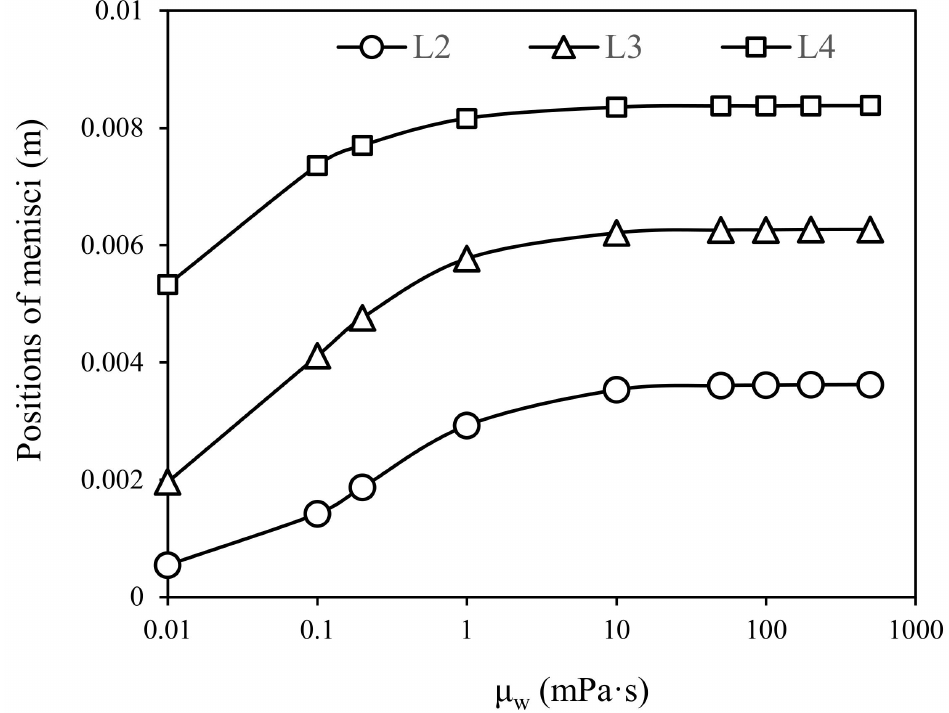
Figure 12. The positions of menisci of imbibition capillaries under different wetting phase viscosities ( µ nw = 1 mPa · s).